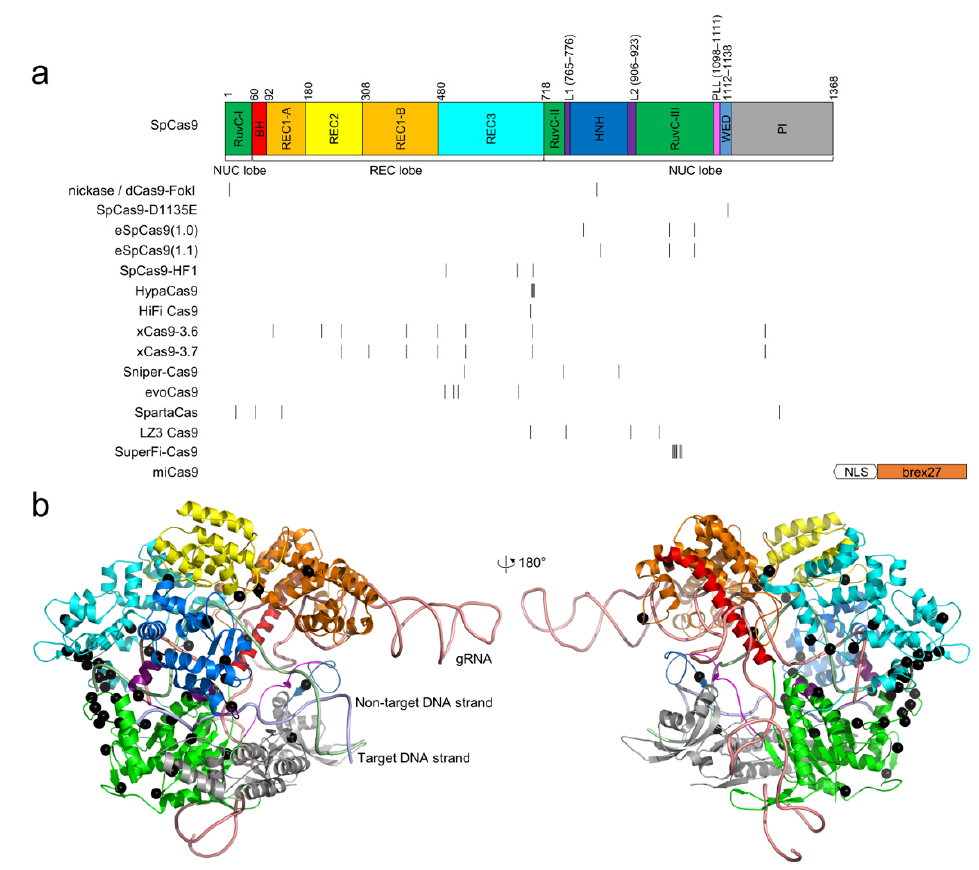
Figure 1. The locations of high-fidelity SpCas9 mutations. ( a ) domain organization of SpCas9. Notably, the domain architecture varies in different literature; the architecture by Huai et al. [67] is used. The positions of the mutated residues for all high-fidelity variants are indicated by black vertical lines. miCas9 contains the fused brex27 motif connected by the SV40 NLS linker instead of point mutations. ( b ) the point mutations, shown as black spheres, are mapped into the structure of SpCas9 (PDB ID: 5F9R) [68]. The color scheme for SpCas9 is identical to that in ( a ). Table 2. Summary of SpCas9 variants for improving editing